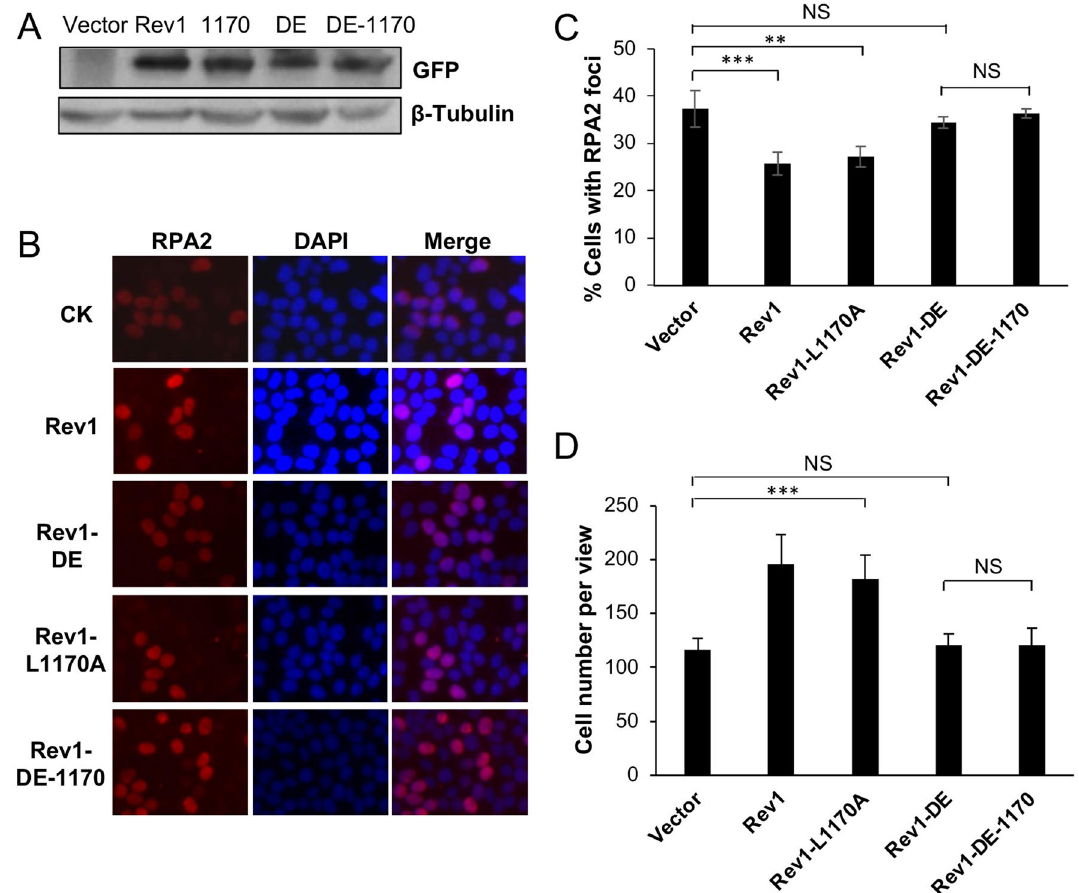
Figure 5. Effects of mRev1 and its mutant derivatives on tolerance to UV irradiation in POLH-1 cells. ( A ) Western blot analysis of transfected GFP-Rev1 and its mutations in POLH-1 cells. ( B ) Representative images of an RPA nuclear focus assay. POLH-1 cells were transfected with plasmids expressing GFP-Rev1 or its mutations for 2 days followed by 2 J/m 2 UV irradiation and incubation for 6 h before staining with DAPI or an antibody against RPA2. ( C ) Quantitative analysis of the RPA2 nuclear focus formation. ( D ) Effects of Rev1 and its mutations on POLH-1 cell growth in response to UV irradiation. Cells were transfected with plasmids expressing GFP-Rev1 or its point mutations for 2 days before 2 J/m 2 UV irradiation, then these cells were cultured for 48 h, followed by counting viable cells. ( C , D ) Results are means of three independent experiments ± SEM. **, P < 0.01; ***, P < 0.001, NS, not significant by two-sided Student’s t